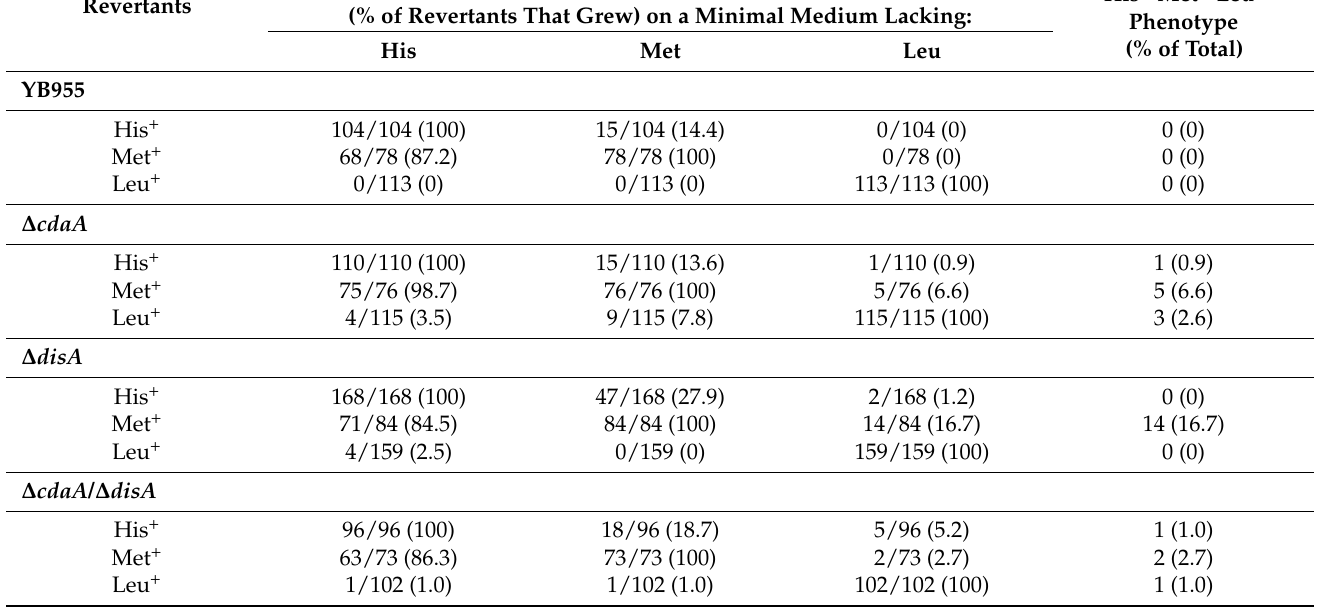
Table 1. Growth of stationary-phase DAC-deficient revertants on alternative selective media a